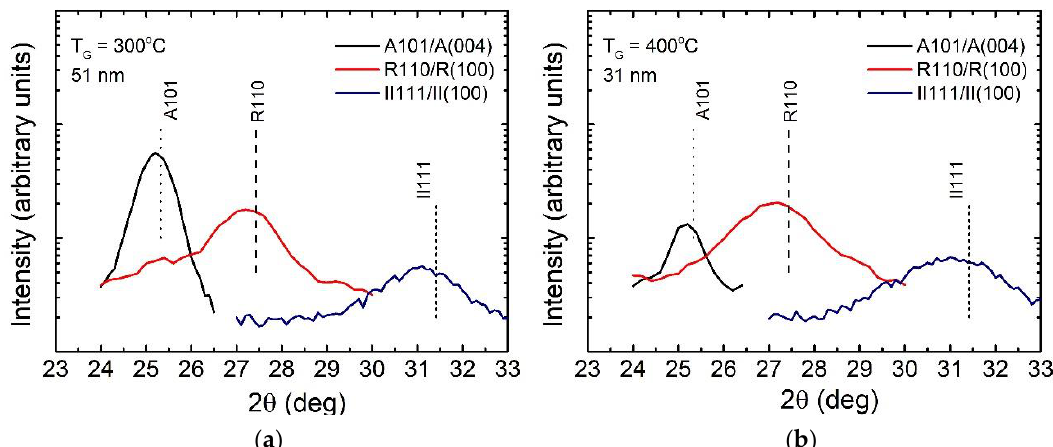
Figure 4. XRD θ-2θ reflections measured from anatase (1 0 1) planes, TiO 2 -II (1 1 1) planes, and rutile (1 1 0) planes of ( a ) 51-nm and ( b ) 31-nm thick TiO 2 films grown on c-sapphire at ( a ) 300 °C and ( b ) 400 °C. The samples were tilted by χ = 68.3° for anatase, χ = 51.0° for TiO 2 -II, and χ = 43.5° for rutile detection.